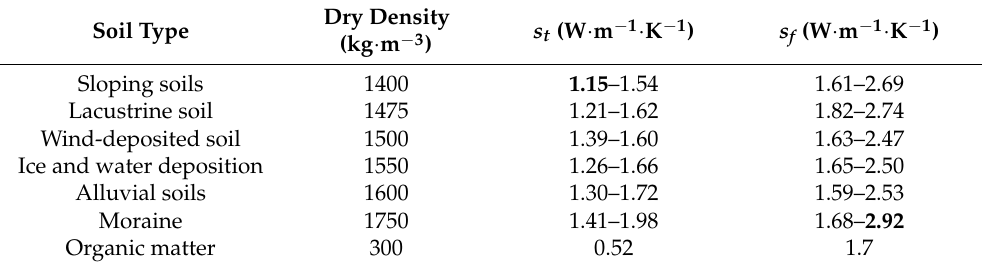
Table 1. Thermal conductivities of typical soil types in Qinghai–Tibetan Plateau in thawing and freezing periods reported by Johansen (1975) [58]. Numbers in bold are the maximum and minimum values, except for organic matter, used in the analysis of this